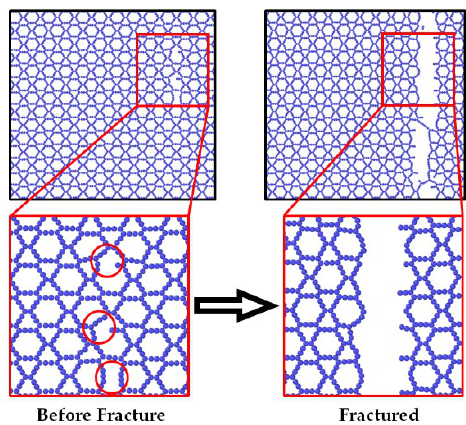
Figure 4. Three‐point vacancies not far apart (3‐c type) are likely to expand into a crack.